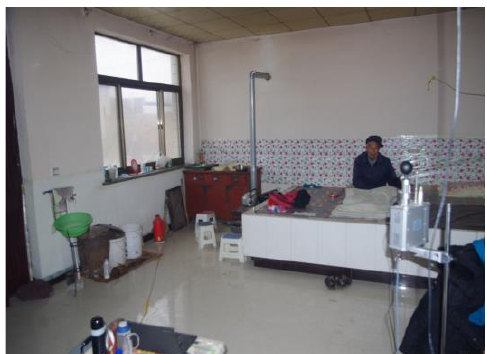
Figure 2. The inside situation of the main bedroom.